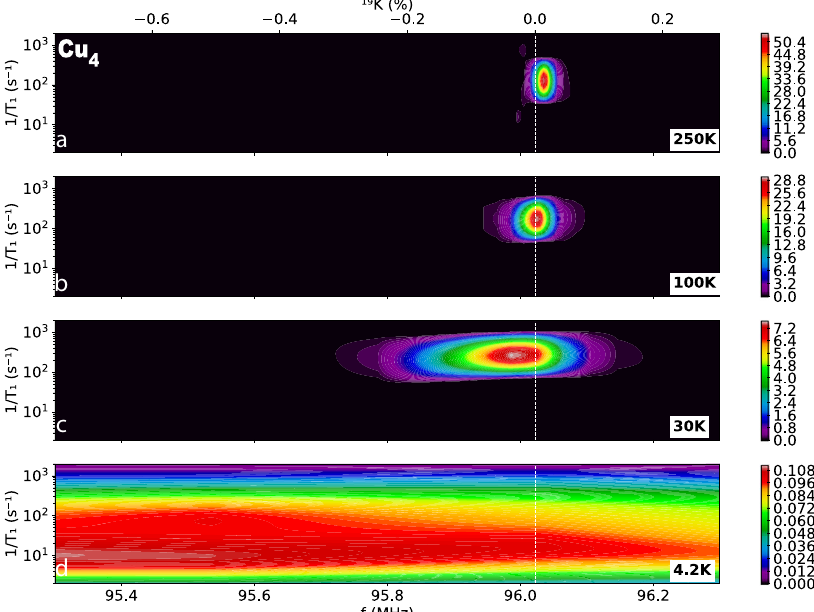
Fig. 9 Two-dimensional correlation map C ( f ; 1/ T 1 ) of Cu 4 . a – d The two-dimensional correlation map C ( f ; 1/ T 1 ) observed for Cu 4 at representative temperatures. The 19 F NMR lineshape gradually broadens below 250 K, as shown in Fig. 2b, toward T N = 15 K, but the distribution of 1/ T 1 is always minimal and roughly symmetrical at all frequencies in the paramagnetic state. Unlike Zn 0.95 , there is no hint of a distinct split-off peak above T N . The drastic change of C ( f ; 1/ T 1 ) at 4.2 K is due to antiferromagnetic long-range order.